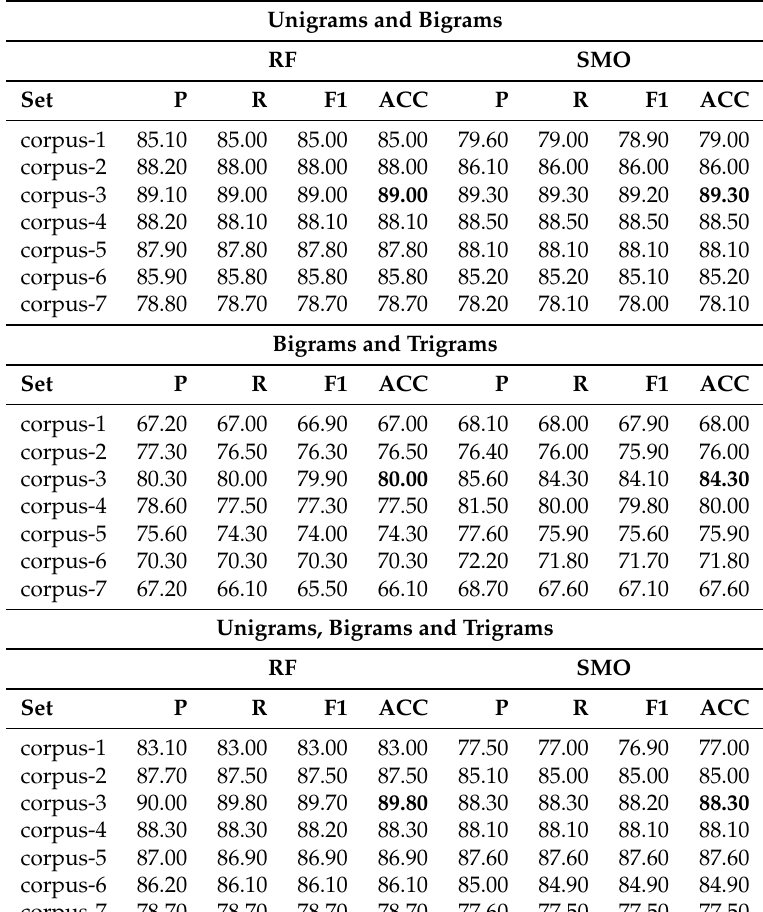
Table 4. Performance of combinations of unigrams, bigrams and trigrams. Unigrams and